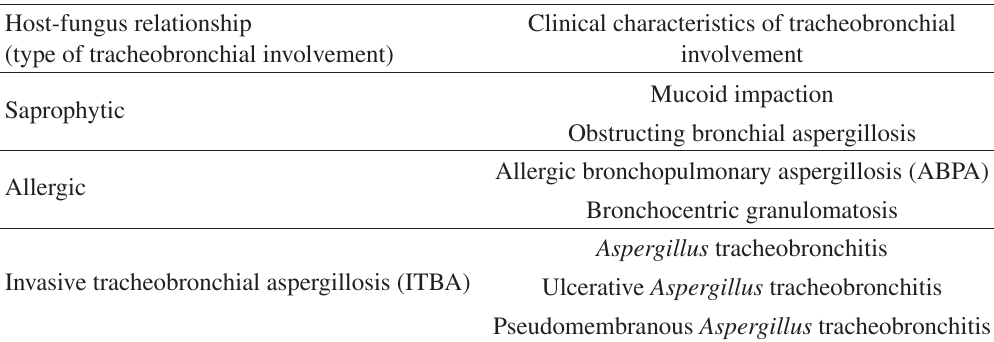
TABLE 2: Classification of Aspergillus -related tracheobronchial diseases (based on